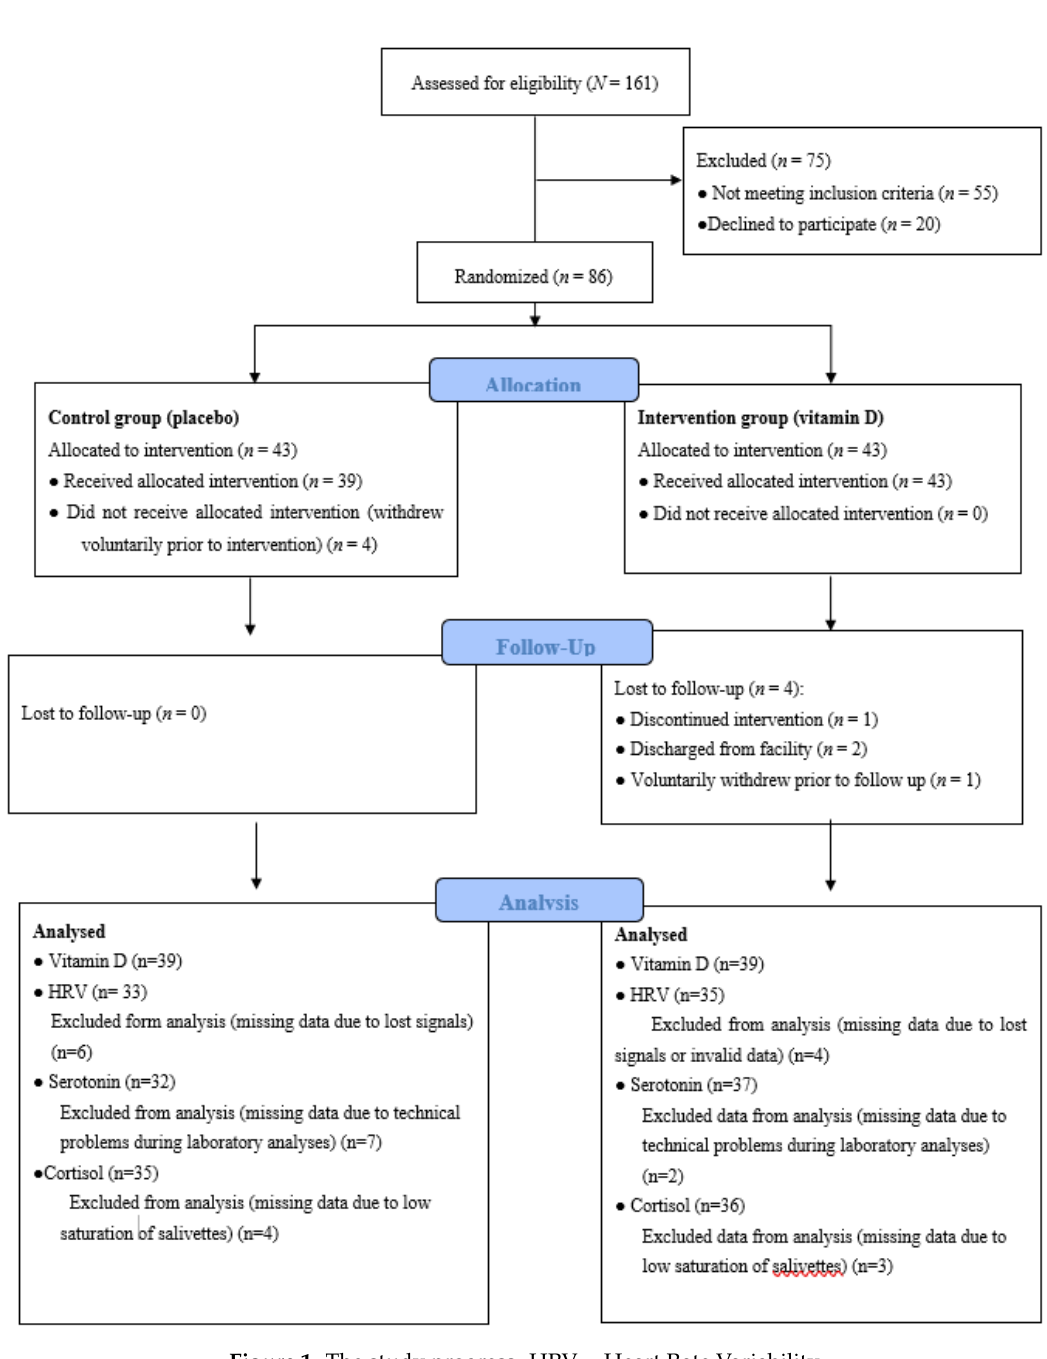
Figure 1. The study progress. HRV = Heart Rate Variability-